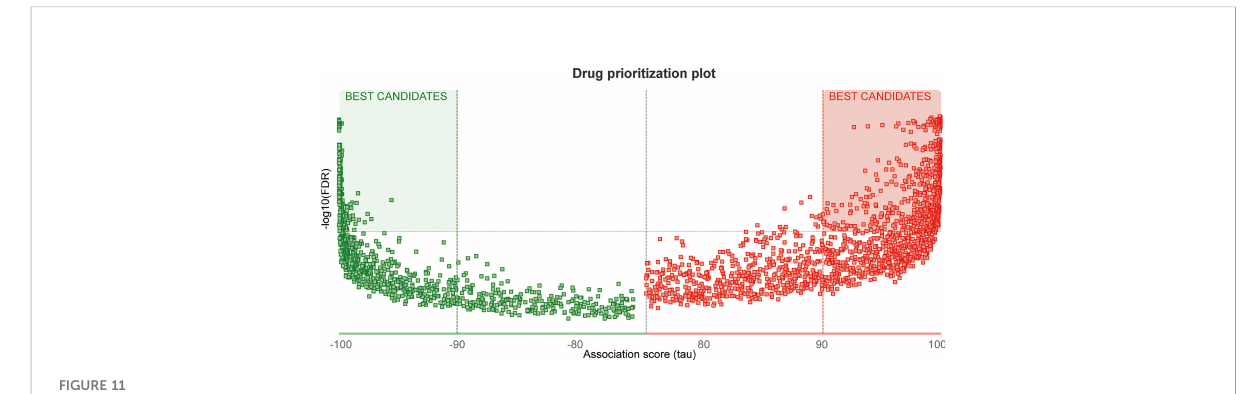
FIGURE 11 Drug screening. Heatmap of the distribution of potential therapeutic